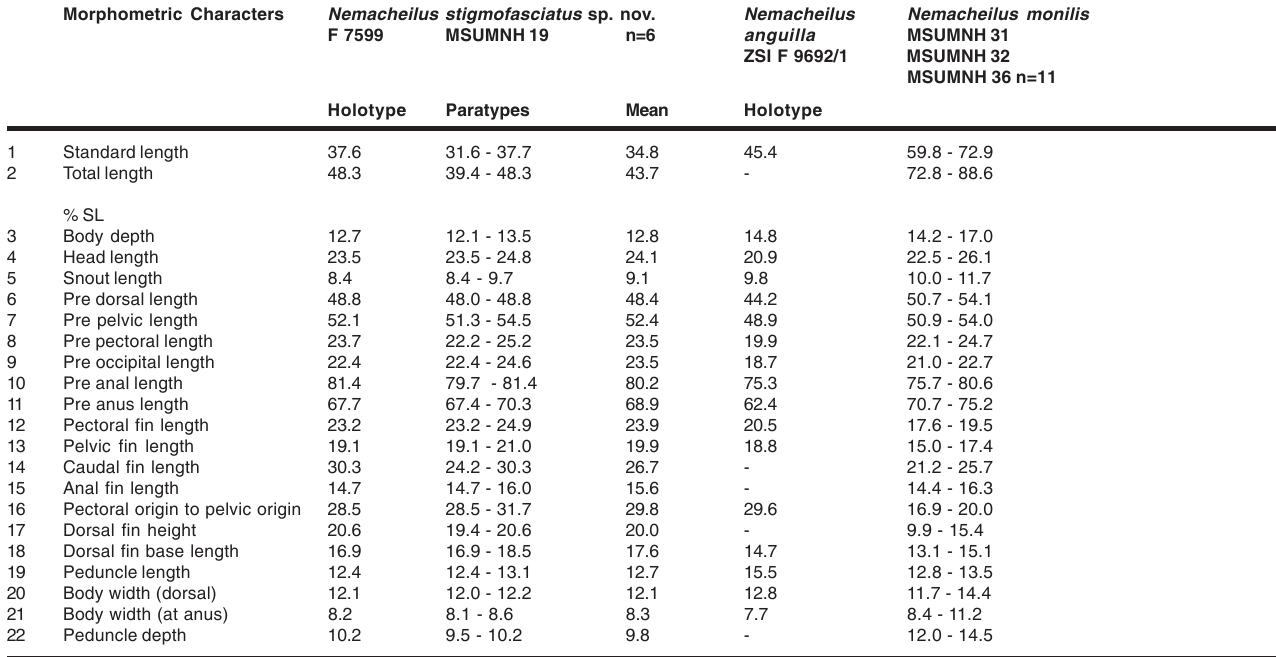
Image 2. Variation in lip structure and barbel length among the three southern Indian nemacheiline species. Table 1. Morphometric data of Nemacheilus stigmofasciatus sp. nov. (Holotype F 7599, ZSI/SRS) and paratypes; Nemacheilus anguilla (Holotype, F 9692/1) and Nemacheilus monilis (MSUMNH 31, MSUMNH 32 and MSUMNH 36). ‘—’ indicates measurement absent due to Morphometric Characters Nemacheilus stigmofasciatus sp. nov.